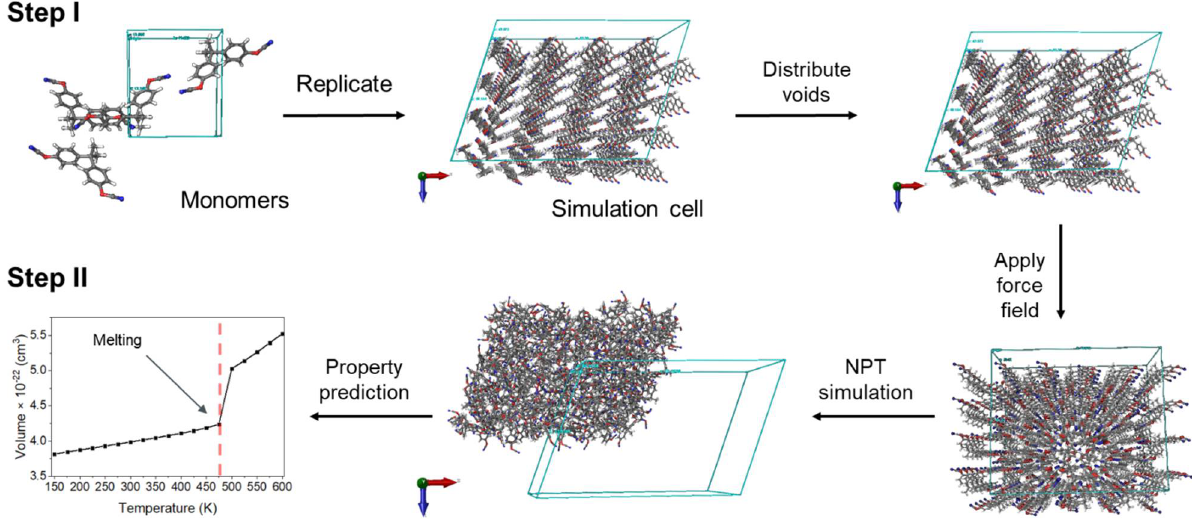
Figure 2. Molecular Dynamics (MD) workflow of melting temperature simulations.